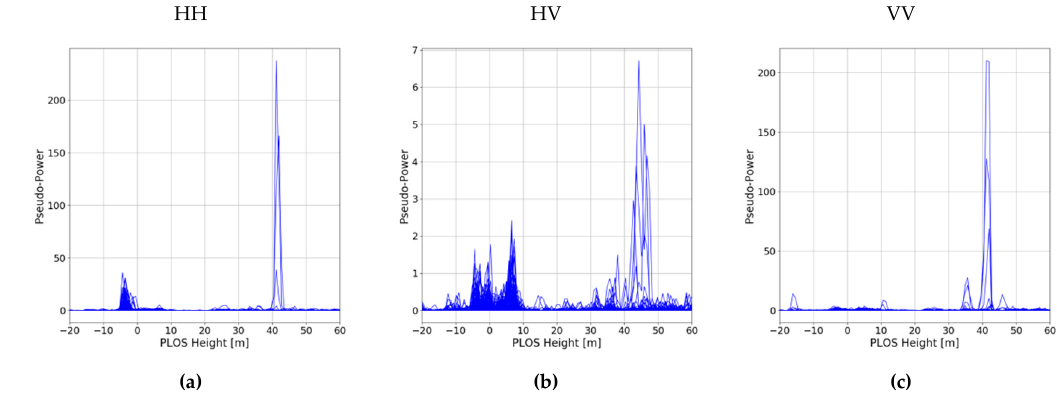
Figure 20. Two hundred and forty-two superimposed vertical profiles spanning about 194 m along azimuth with a 1.2° slope, taken from the tomograms displayed in Figure 19. We perform focusing using DCRCB + WISE for three polarizations: ( a ) HH, ( b ) HV and ( c ) VV. The (pseudo) power is presented in a linear scale.